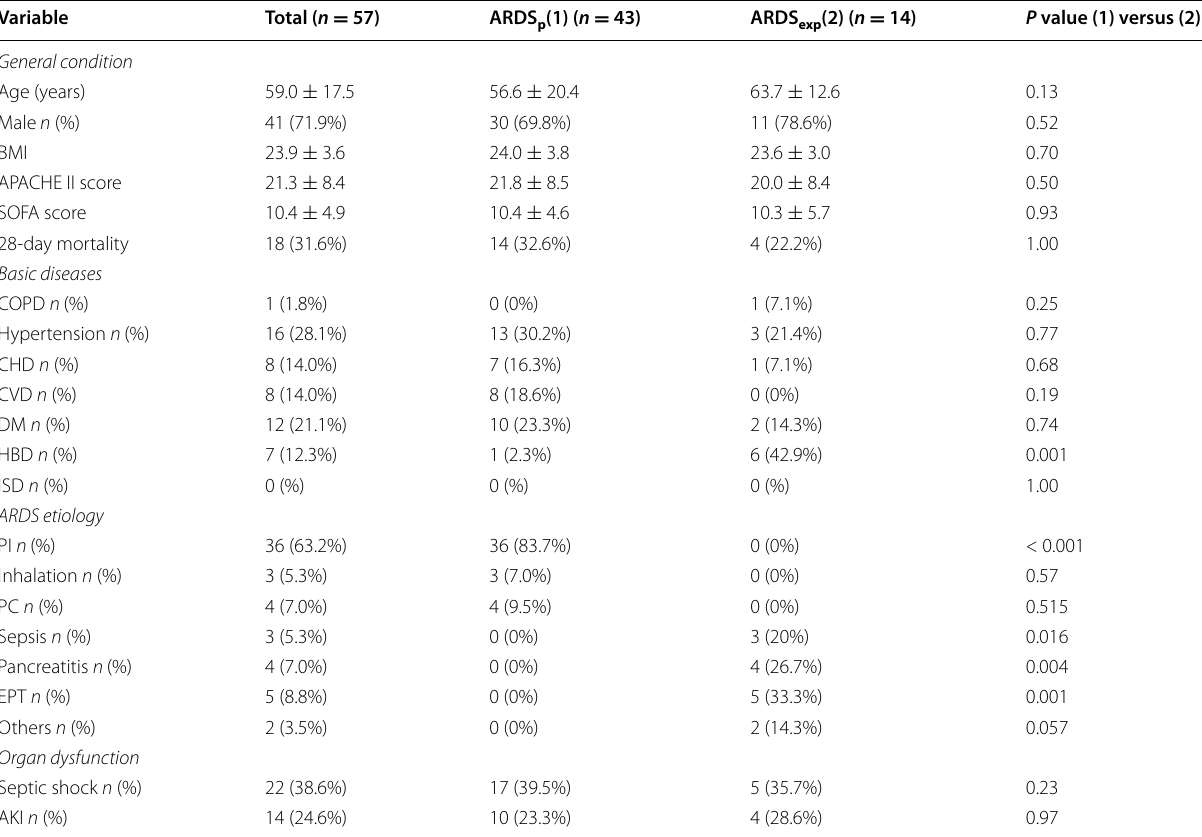
Table 2 General data comparison between ARDSp and